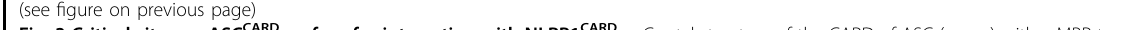
Fig. 3 Critical sites on ASC CARD surface for interacting with NLRP1 CARD . a Crystal structure of the CARD of ASC (green) with a MBP tag (gray) at 2.0 Å resolution. b Comparison of the initial ASC CARD subunit model (green) and the subunit structure after re fi nement against the cryo-EM density (gray, PDB ID: 6N1H). c Superposition of all six known CARD structures, showing the highly conserved CARD structure. d Superposition of the ASC/ ASC dimers with RAIDD/PIDD dimers in the Type I, II, and III interactions. e Measurement of the self-interaction of wild-type ASC CARD by the M2H experiment. Luciferase activity in the HEK293T cells was normalized to Renilla and data were presented as the fold of negative control. Mean values ± SEM are representative of three independent experiments. f Structure-based sequence analysis of the ASC CARD protein. Amino acid position is indicated on the top. GenBank accession numbers for ASC CARD : Human (NP_037390.2); Mouse (NP_075747.3); Small-eared-galago (XP_003795885.1); Bovine (NP_777155.1); Guinea pig (XP_003478302.1); Giant panda (XP_002924797.1); and Zebra fi sh (NP_571570.2). g Mapping important ASC CARD surface sites for interaction with NLRP1 CARD by Y2H analysis. Three individual clones for each combination were plated. h Size-exclusion chromatograph of the mixture of MBP-ASC CARD-DE and NLRP1 CARD . ASC CARD-DE was fused with an N-terminal His-tag and incubated with untagged NLRP1 CARD , which was fi rst puri fi ed by Ni-af fi nity chromatography. The protein eluted in the less aggregated position on a Superdex TM 24 gel fi ltration column. i Size-exclusion chromatograph of the mixture of MBP-ASC CARD-NE and NLRP1 CARD . ASC CARD-NE was fused with an N-terminal His-tag and incubated with untagged NLRP1 CARD , which was fi rst puri fi ed by Ni-af fi nity chromatography. The protein eluted in the less aggregated position on a Superdex TM 24 gel fi ltration